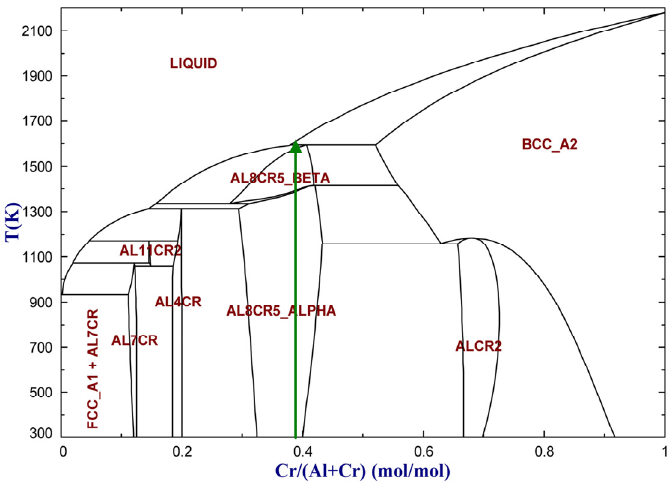
Figure 4. Binary phase diagram of Cr and Al from FactSage 7.3 databases [33].